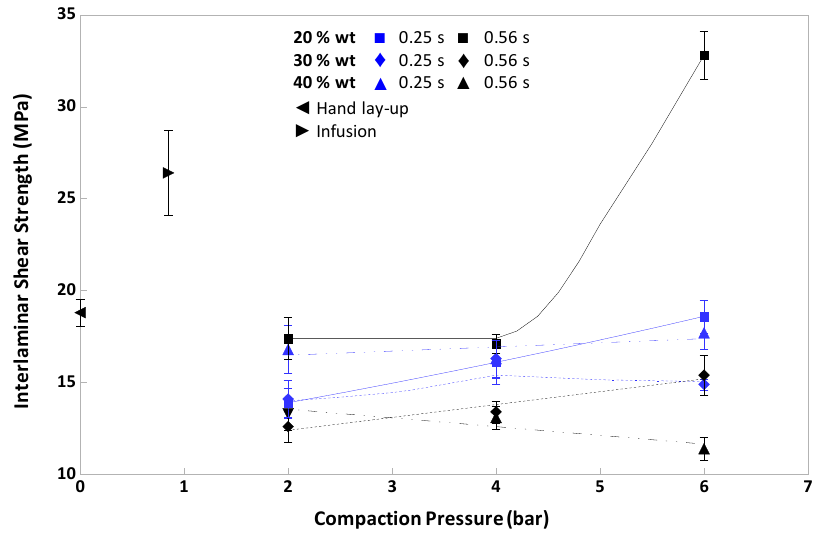
Figure 14. Interlaminar shear strength of the composites with prepreg fibre contents of 20 ( ■ ), 30 ( ♦ ) and 40 wt.% ( ▲ ) and an initial exposure time of 0.56 s. Additionally, those with prepreg fibre contents of 20 ( ■ ), 30 ( ♦ ), and 40 wt.% ( ▲ ) and an initial exposure time of 0.25 s vs. the compaction pressure.